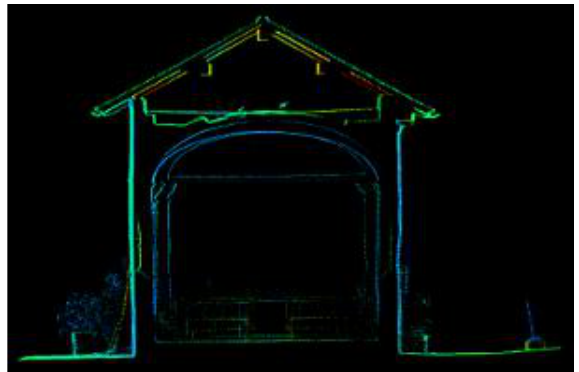
Figure 6. Cloud point and CAD planimetry overlapping for accuracy evaluation. Blueprints extracted from Ilaria Gelmo e Francesco Toso’s thesis were useful as a preparatory sketch during the survey and they were used for comparison with the new lidar survey. Vertical sections allow to investigate construction elements and to extract information and data regarding structural element inside a unitary 3D model obtained through the unification of all scans.